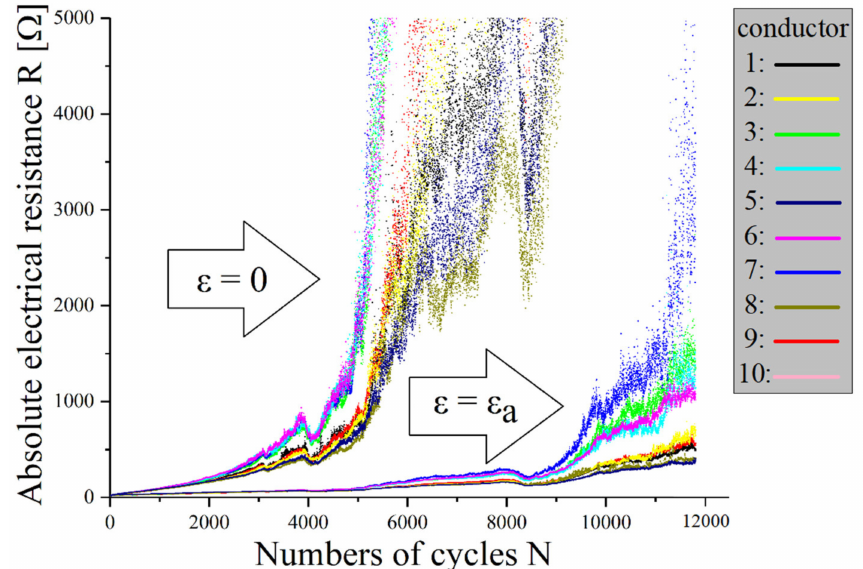
Figure 9. Electrical resistance changes of elastic textile / polymer composite-based stretchable electronics with conductors made of silver-plated knitted textiles under cyclic mechanical load at a strain amplitude of 22.1%. For definition of measurements, see Figure 6.